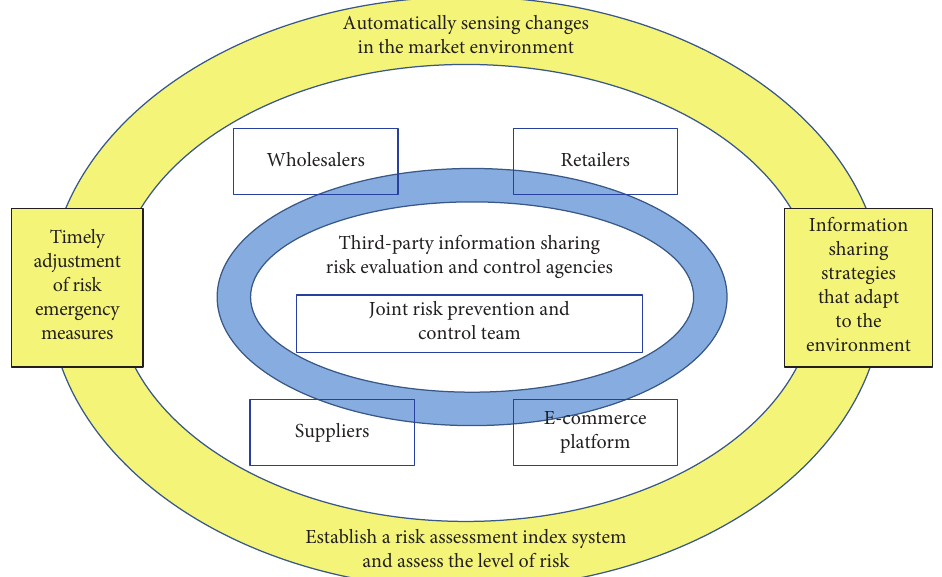
Figure 4: Risk evaluation and control mechanism of information